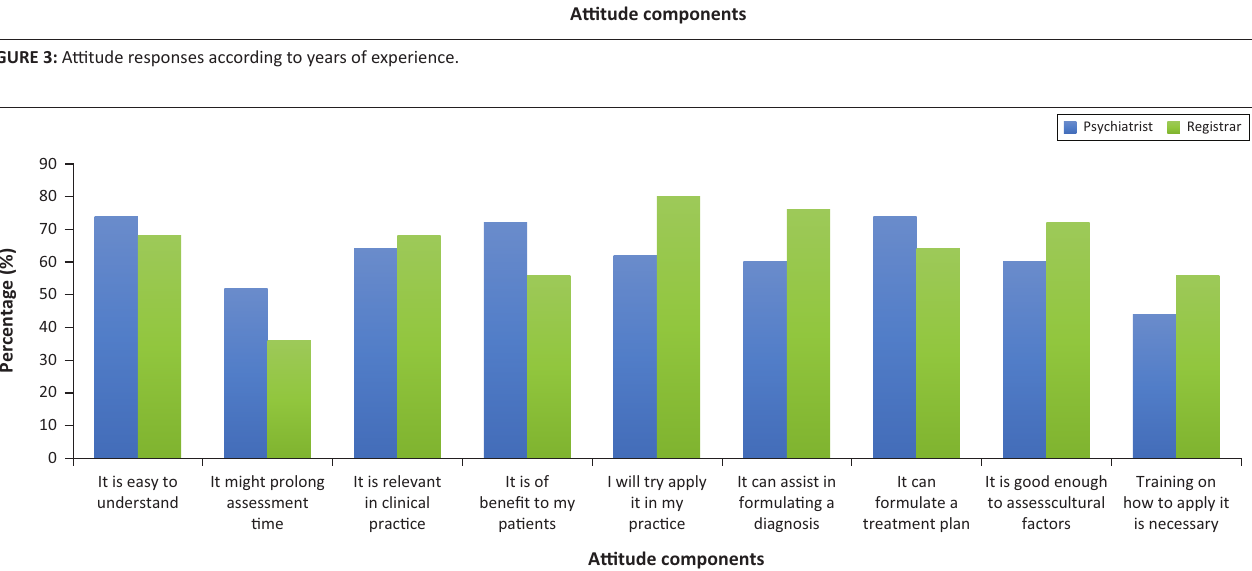
FIG URE 4: Attitude responses of psychiatrists versus registrars (psychiatrists in